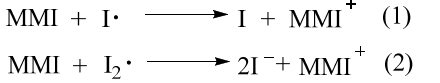
Figure 3. Mixing of ionic liquid system and starch solution: ( a ) without Au 0 , ( b ) with Au 0 . Thiamazole (MMI) is an inhibitor of iodine free radicals [27]. It reacts with iodine free radicals as Scheme 1 to inhibit the oxidation of free radicals, and it will not affect the coordination of ionic liquids.